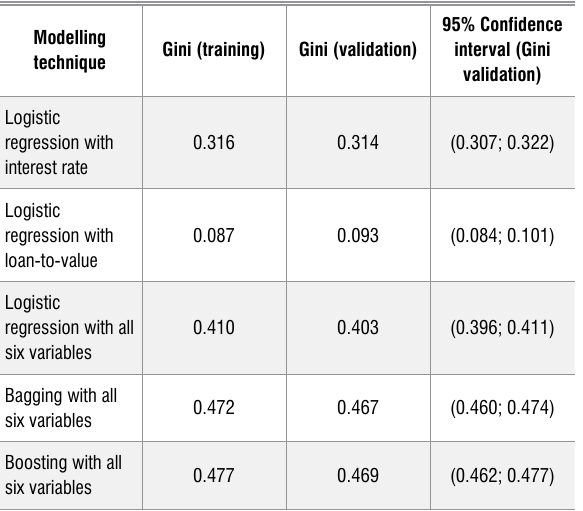
Gini results of different modelling techniques used Modelling technique